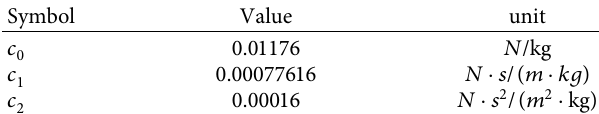
Table 2: Resistance coefficients of the high-speed train.